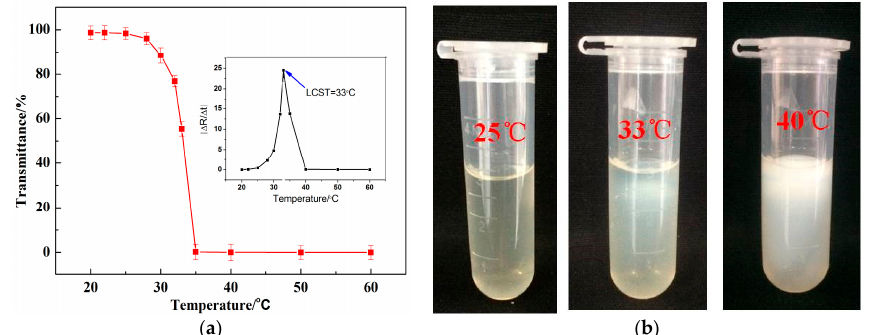
Figure 4. Thermosensitive behavior of the PNIPAAm/chitosan hydrogels: ( a ) Temperature dependence for the optical transmittance; ( b ) Photograph of the hydrogels at different temperatures. Data are presented as mean ± standard deviation.